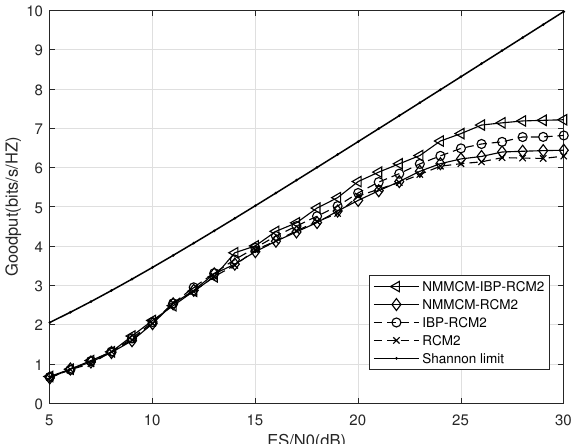
Figure 7. Goodput comparison in different system with weight set {± 1, ± 2, ± 4, ± 4 } .